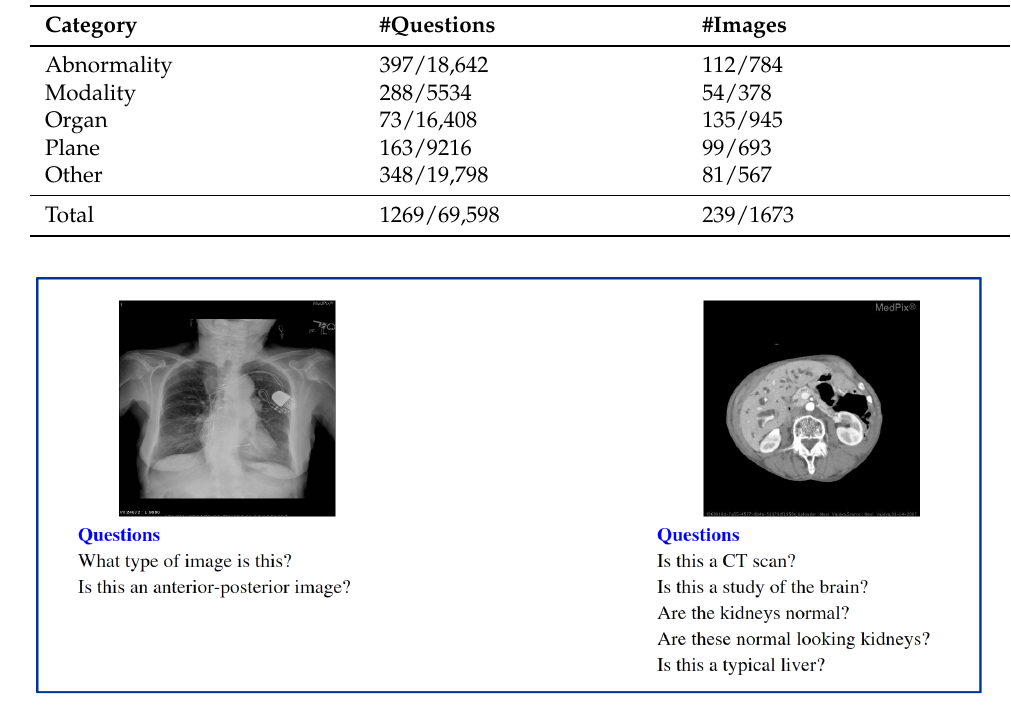
Figure 6. Sample radiology images and the associated questions from the VQA-RAD dataset.